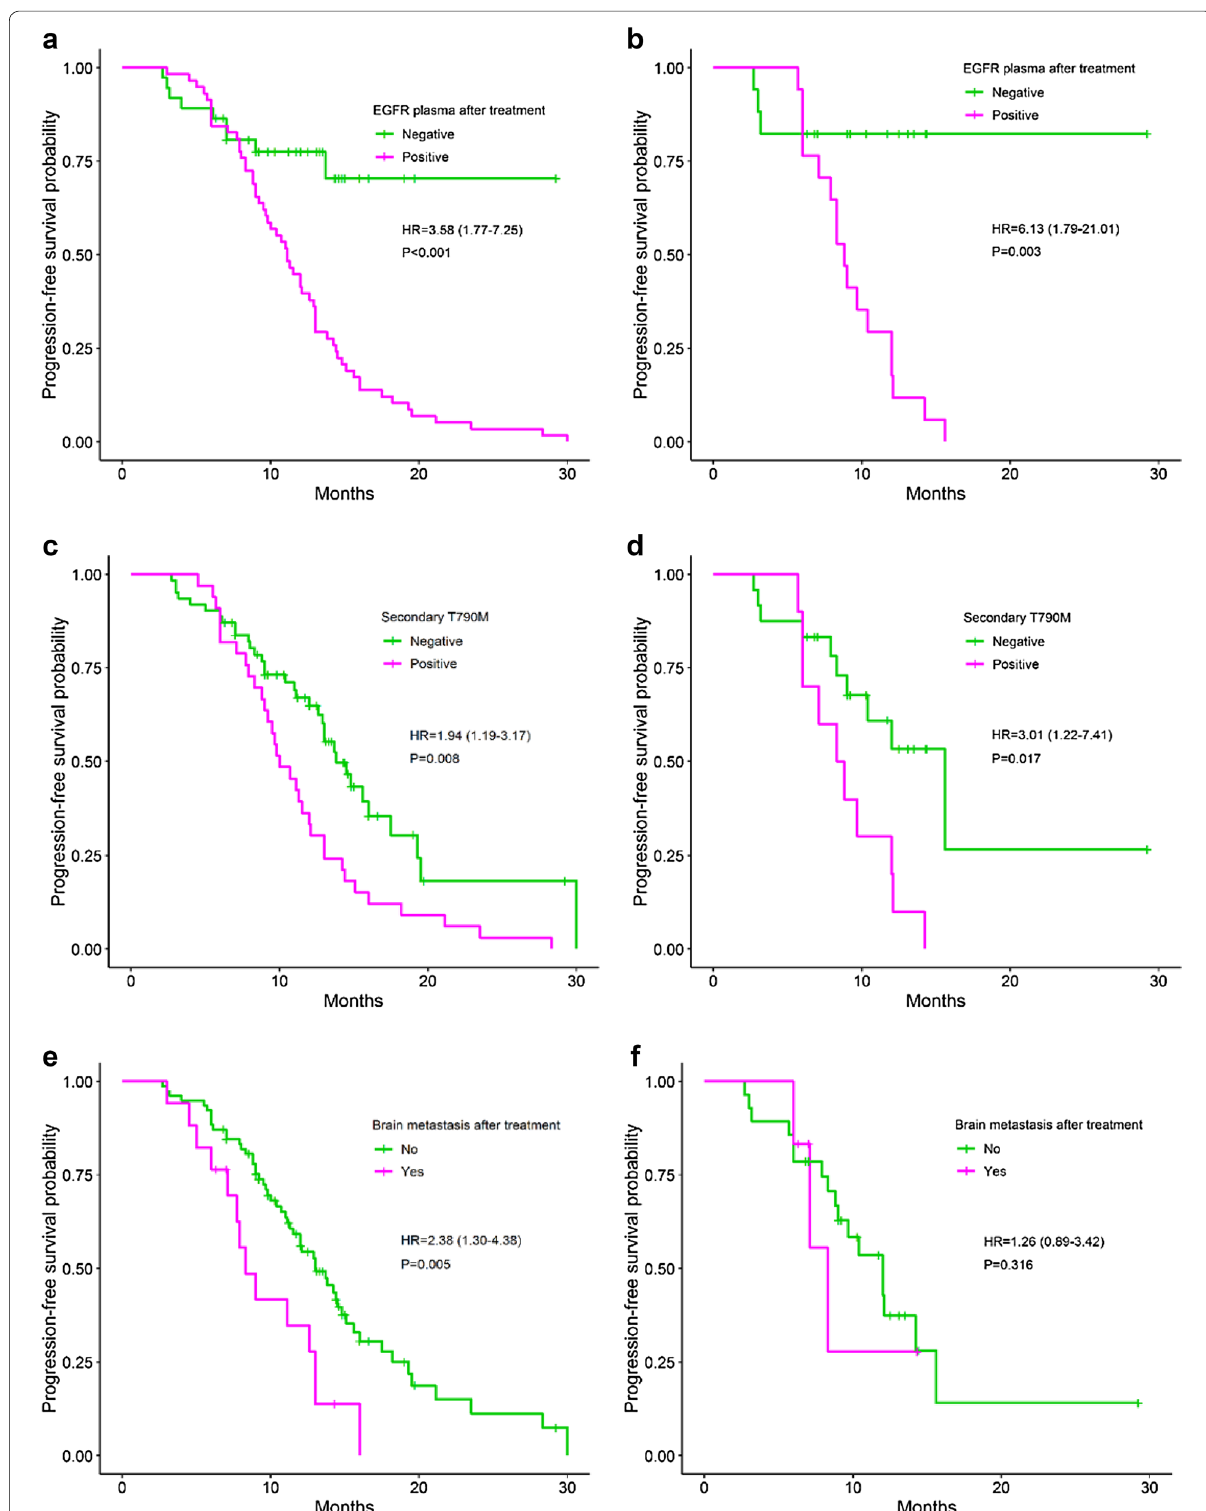
Fig. 2 Progression‑free survival between groups: EGFR plasma after treatment ( a £ , b ǂ ); secondary T790M mutation ( c £ , d ǂ ); brain metastasis after treatment ( e £ , f ǂ ). £: all patients; ǂ : the newly diagnosed group. EGFR epidermal growth factor